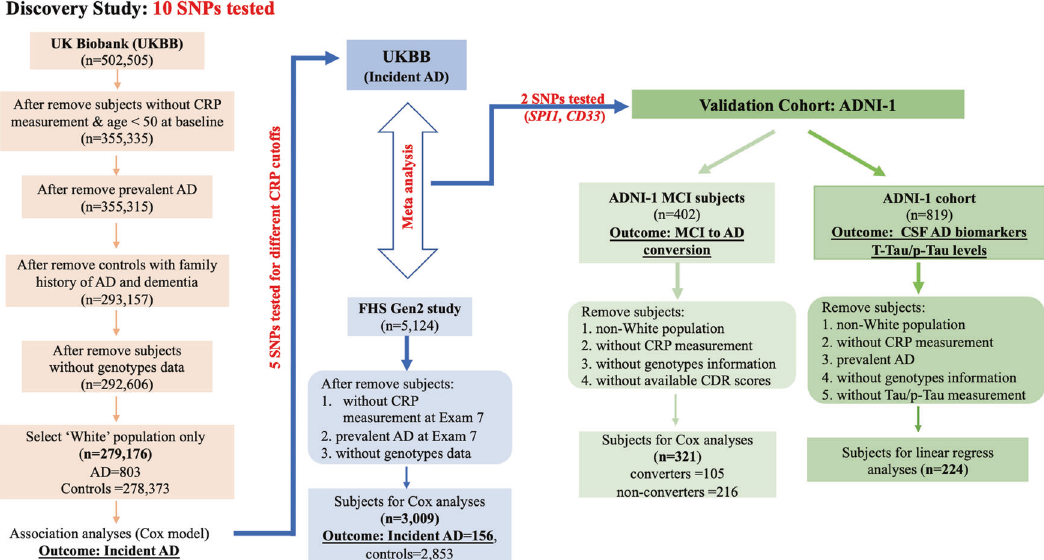
Fig. 1 Study design and fi lters for UKBB, FHS and ADNI cohorts. The following three human datasets were analyzed in this study. UKBB : 279,176 participants (mean age 60.1 ± 5.5 years) of which baseline CRP was measured, and 803 incident AD cases were identi fi ed after 8.3 ± 0.9 years of follow-up. FHS : 3009 participants (mean age 60.8 ± 9.4 years) of which baseline CRP was measured (i.e., Exam 7), and 156 incident AD cases were identi fi ed after 14.9 ± 4.0 years of follow-up. ADNI : 321 MCI patients (mean age 75.0 ± 7.0 years) of which baseline CRP was measured, and 105 MCI-to-AD converters were identi fi ed after 31.8 ± 11.2 months of